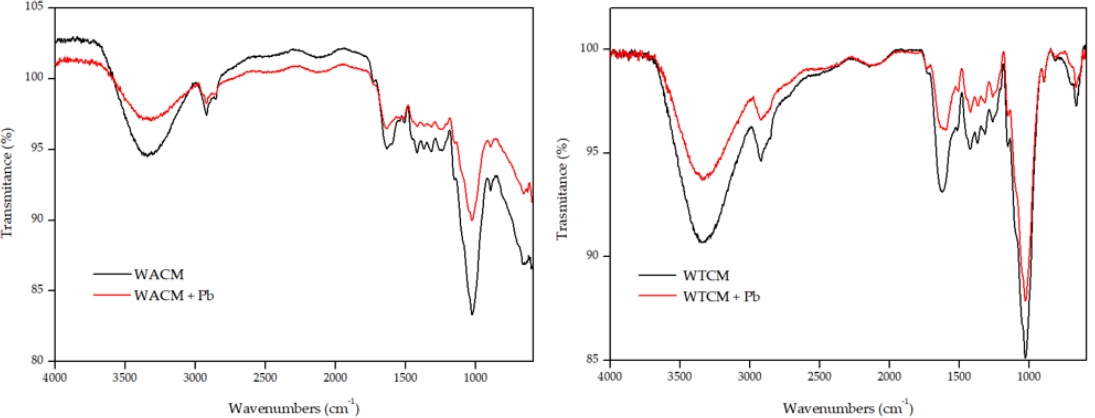
Figure 4. FTIR spectra before (black) and after (red) Pb(II) adsorption by WACM ( left ) and WTCM ( right ). pH 4, C 0 = 130.8 mg L 1 , T = 293 K, t = 120 min.